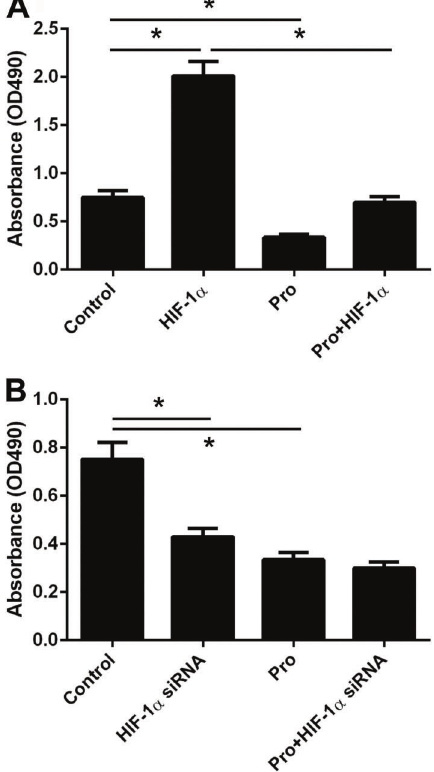
Figure 3. Overexpressed hypoxia inducible factor-1 a (HIF-1 a ) hemangioma cells ( A ) and knockdown hemangioma cells ( B ) were treated or not with 50 m M propranolol (Pro) for 48 h. Cell proliferation was measured by CCK-8 kit assay. Data are reported as means ± SD of one representative experiment of at least three experiments with quintuplicates or sextuplicates. *P o 0.05